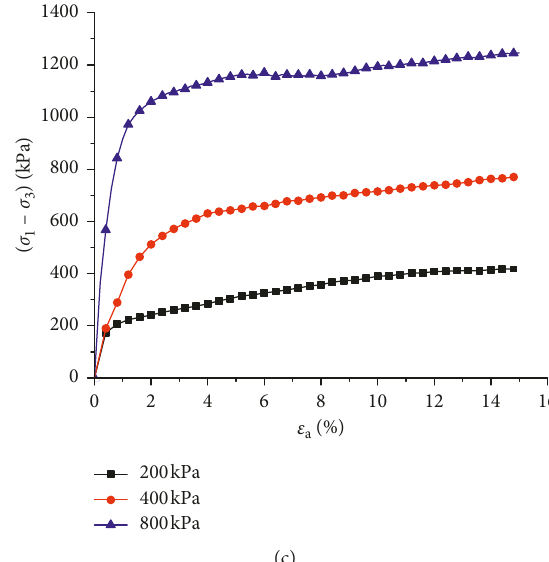
Figure 11: Stress-strain relationship of samples under different random positions: (a) random position 1; (b) random position 2; (c) random position 3.